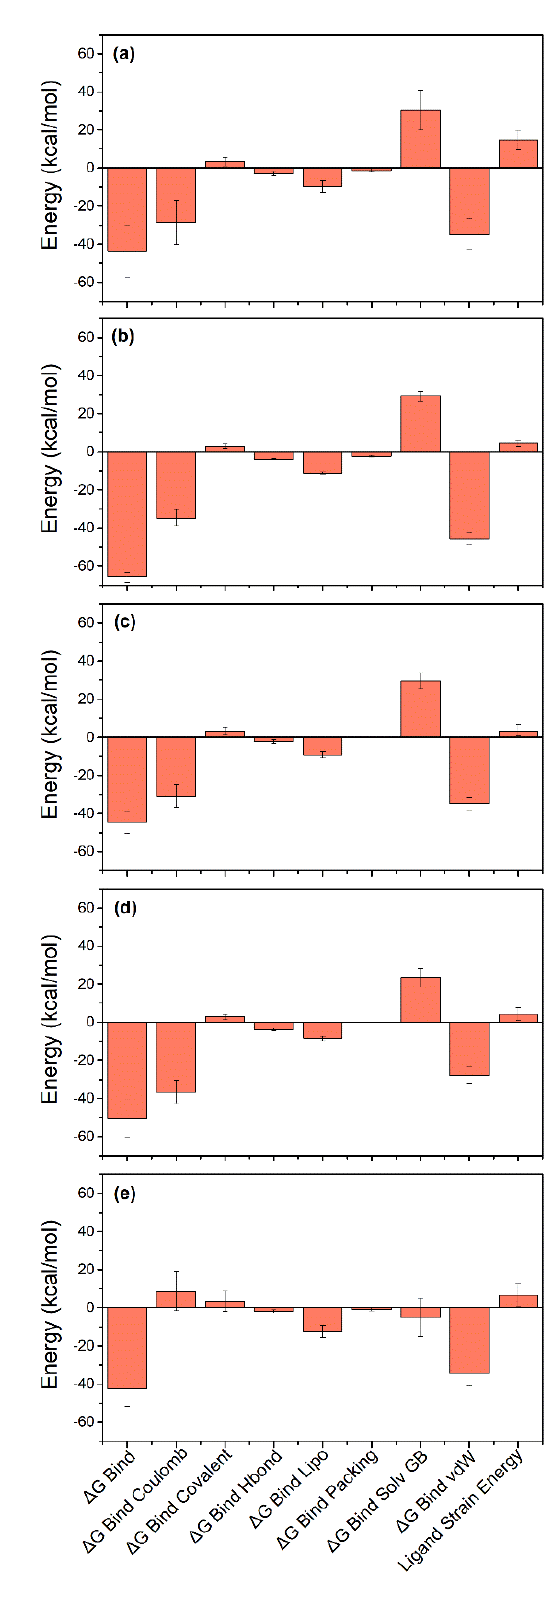
Figure 10. Average binding free energy and their dissociation energy components calculated for the extracted poses of SARS-CoV-2 M pro with potent natural products, i.e., ( a ) Echinacoside, ( b ) Quercetagetin 7-glucoside, ( c ) Levan N, ( d ) Inulin from chicory, and ( e ) 1,3-Dicaffeoylquinic acid, from respective 100 ns MD